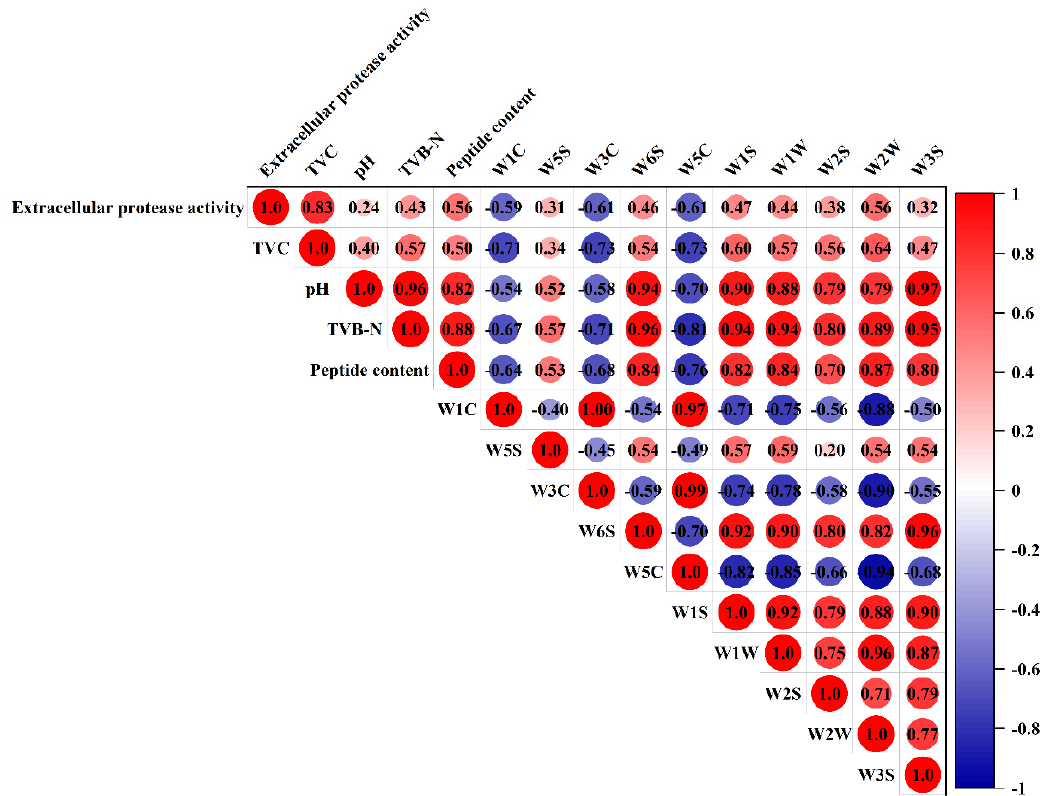
Figure 5. Correlation analysis among extracellular protease, TVC, pH, TVB − N, peptide content, and 10 E-nose volatile odor sensors.